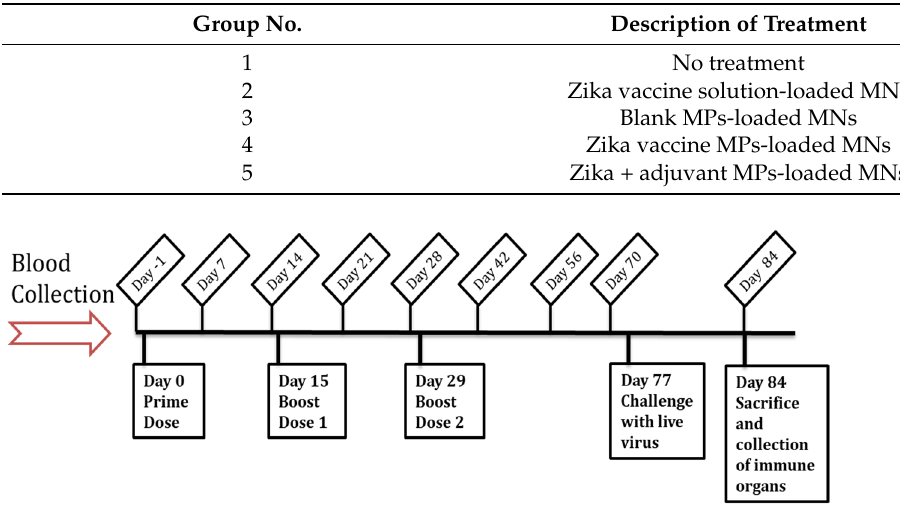
Figure 1. Timeline of the in vivo assessment of Zika vaccine MPs-loaded dissolving